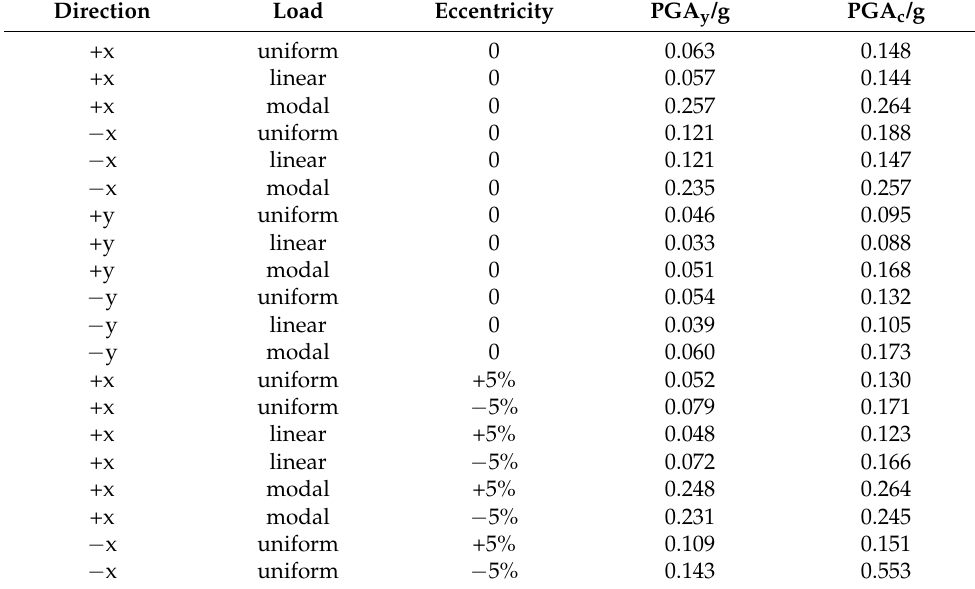
Table 2. Values of PGA y and PGA c